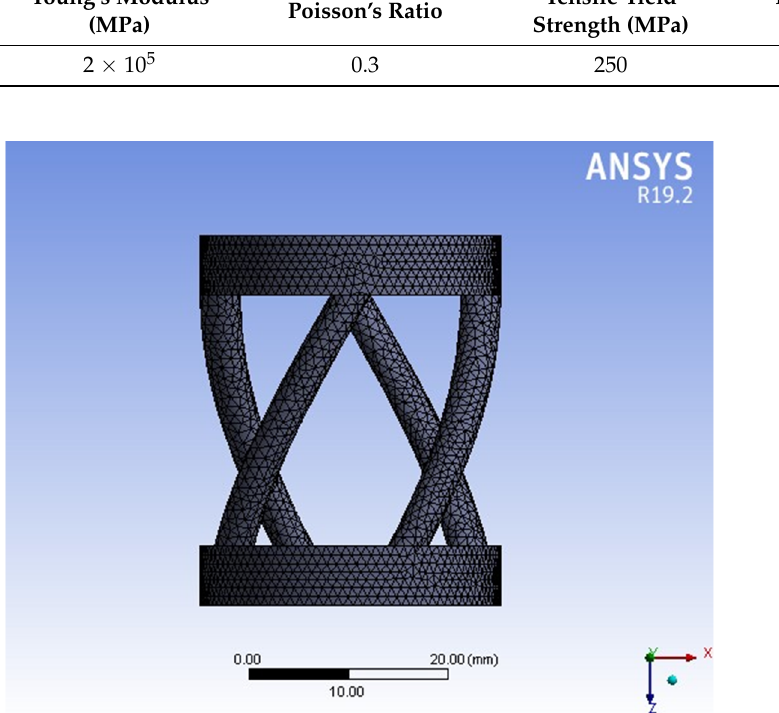
Table 2. Structural steel’s isotropic elasticity by FEM (Ansys Workbench).